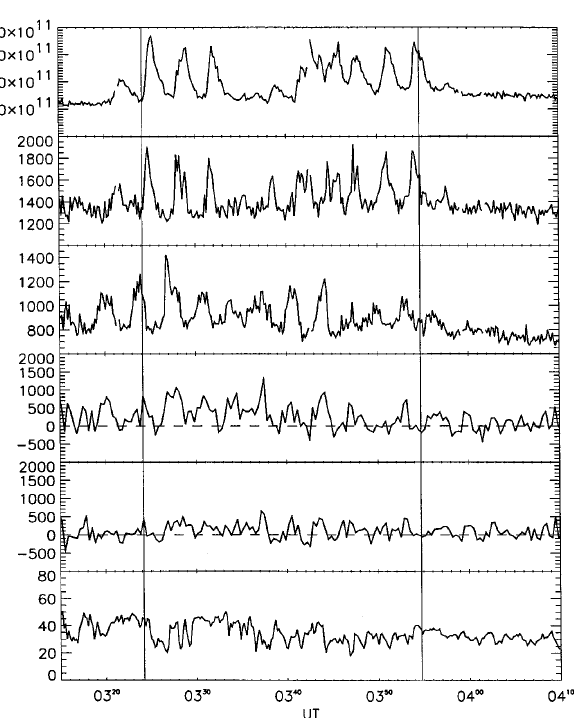
conductivity Hall conductivity. a covers the time interval 0200 to 0500 UT and b the interval 0315 to 0410 UT. The vertical lines in a identify the three separate intervals of ULF wave activity as described in